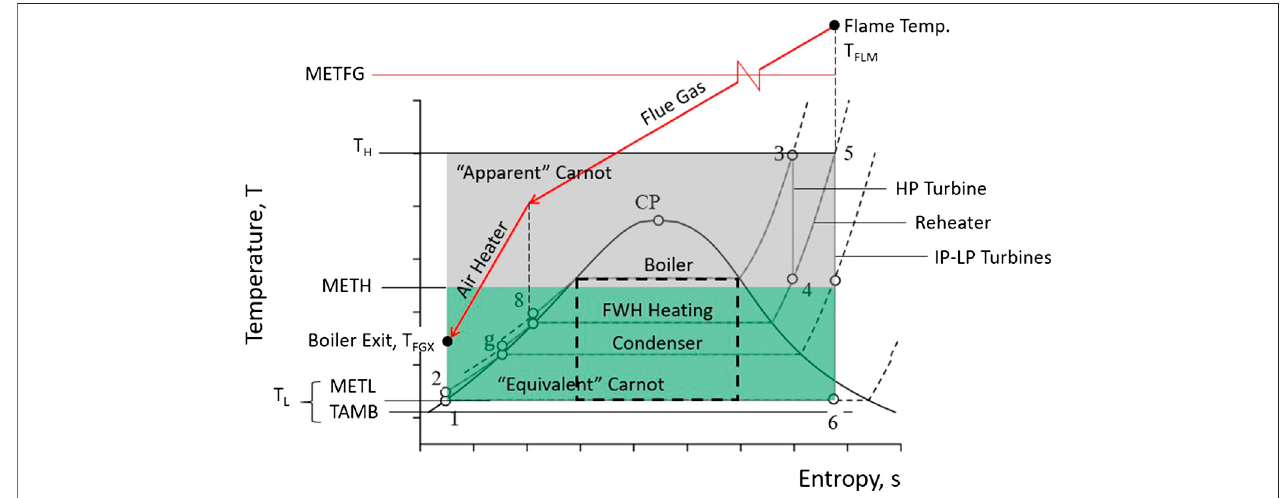
FIGURE 1 | Temperature-entropy diagram of Rankine steam cycle with reheat and feed water